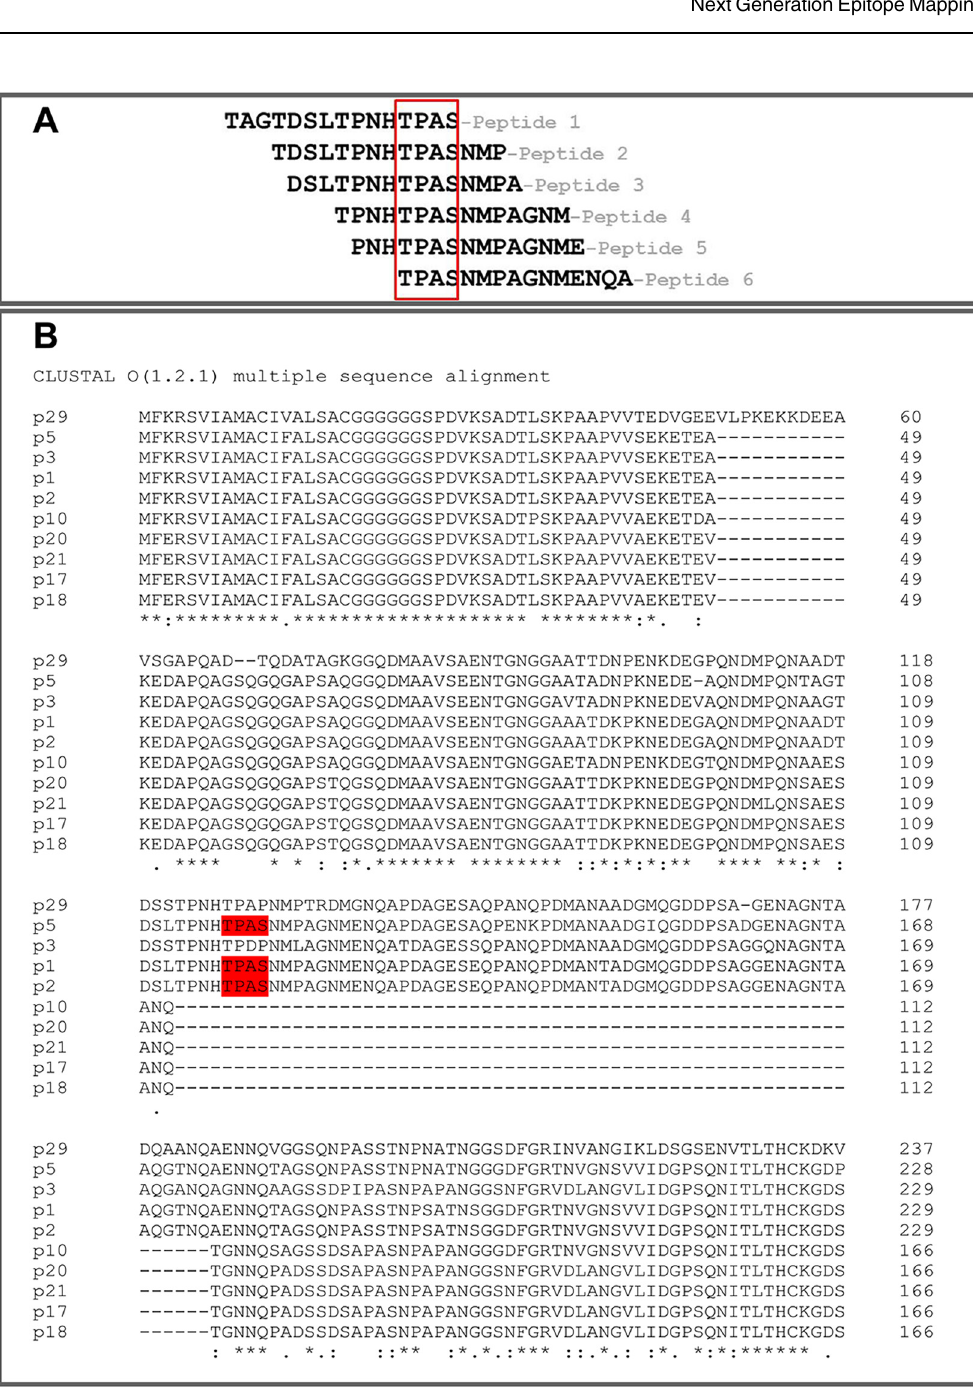
Fig 5. Immunoreactivity of mAb3 1E10/E7 against a panel of overlapping 15-mer peptides spanning the entire sequence of ten different NHBA variants (p1, p2, p3, p5, p10, p17, p18, p20, p21 and p29) spotted in a microarray. A, Aminoacid sequences of the six 15-mer peptides, which produced high reactivity values (MFI > 30,000) in peptide microarray assays. Shown are results from one experiment, representative of three separate ones, each performed using 3 replicates per peptide. Raw data from all experiments are available under accession number GSE81379 at the National Center for Biotechnology Information ’ s Gene Expression Omnibus database. The red box indicates the TPAS consensus sequence common to all reactive peptides. B, multiple sequence alignment of the N-terminal regions of the NHBA variants containing the TPAS consensus sequence (highlighted in red). Dashes (-), missing residue; asterisk ( * ), position with a fully conserved residue; colon (:), conservation of residues with strongly similar properties ( > 0.5 in the Gonnet PAM matrix); period (.), conservation of residues with weakly similar properties (= or < 0.5 in the Gonnet PAM